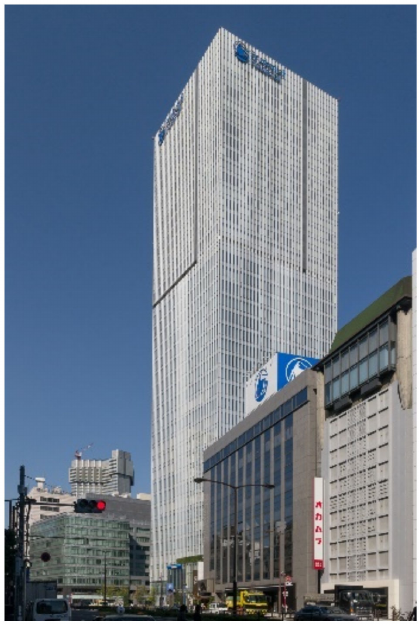
Figure 9. Prudential Tower in Tokyo https://upload.wikimedia.org/wikipedia/commons/3/37 /Prudential-Tower-Tokyo-01.jpg (accessed on 15 October 2022).